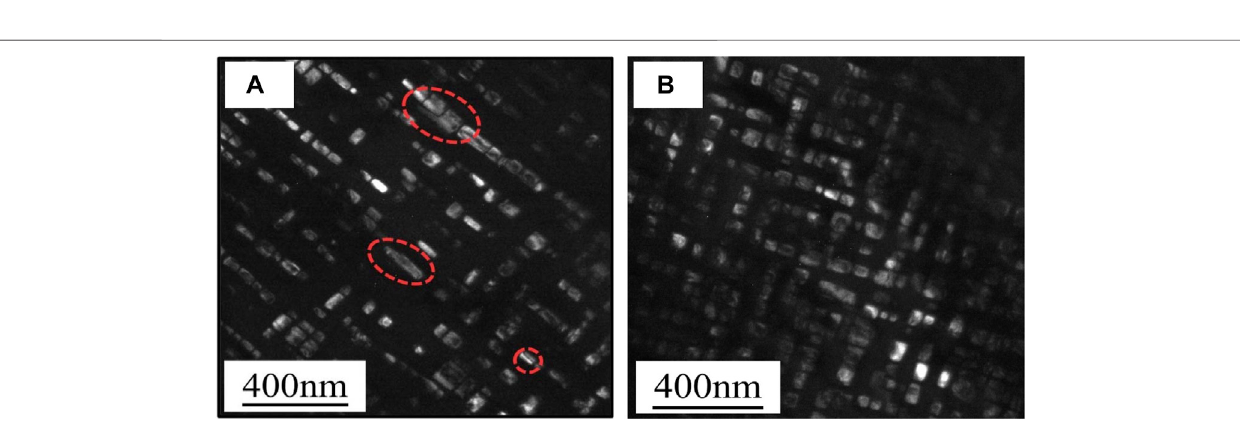
FIGURE 9 | The TEM micrographs of typical microstructures in superalloys after being aged for 32 h at 1073 K: (A) 2Cr, (B) 2Mo.